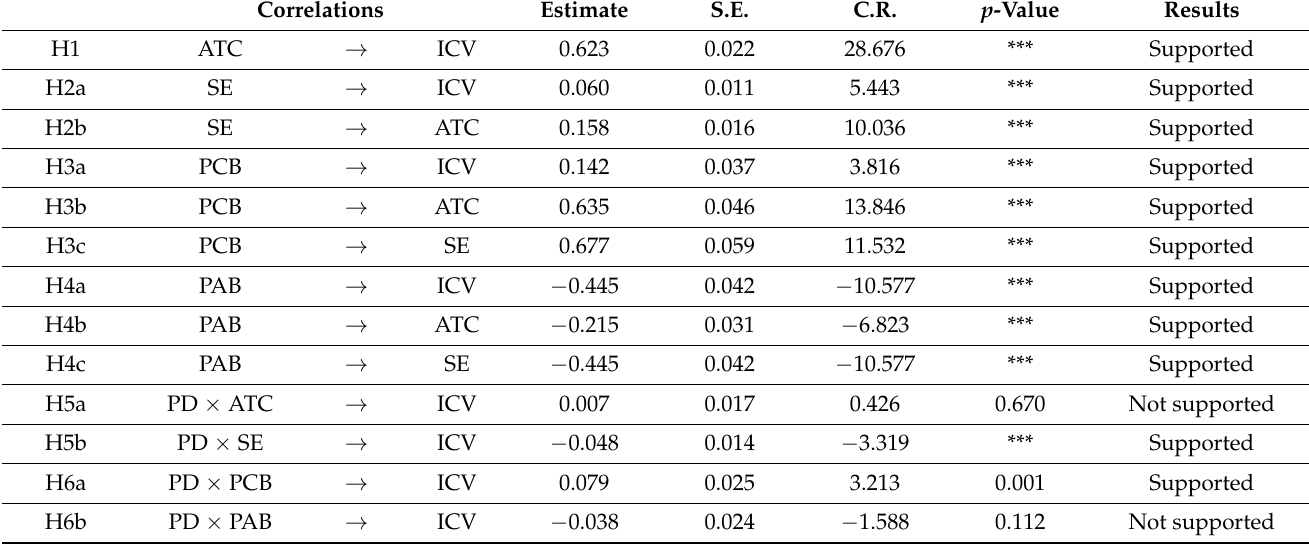
Table 4. Correlations between